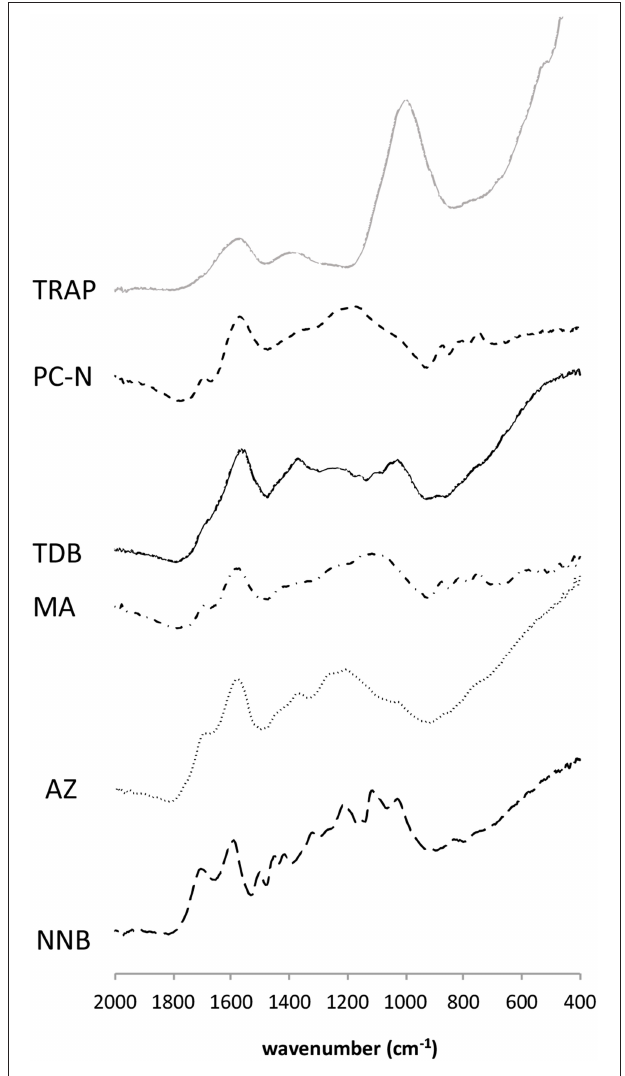
FIGURE 4 | FTIR spectra of all samples. As discussed in the text, the figure focuses upon the “fingerprint” region between 400–2,000 cm − 1 .